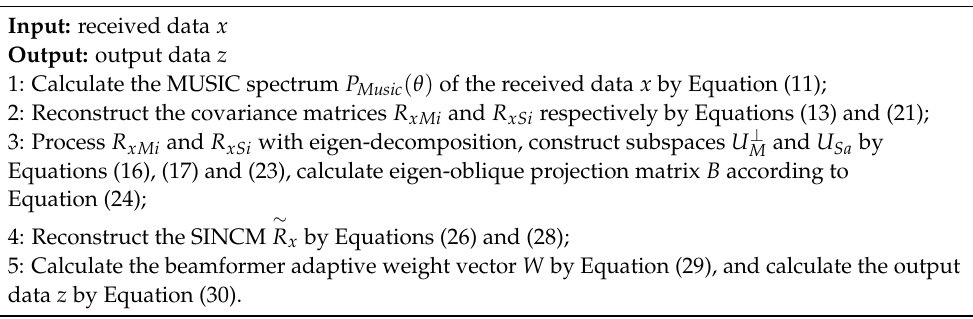
Algorithm 1 Multiple mainlobe interferences suppression